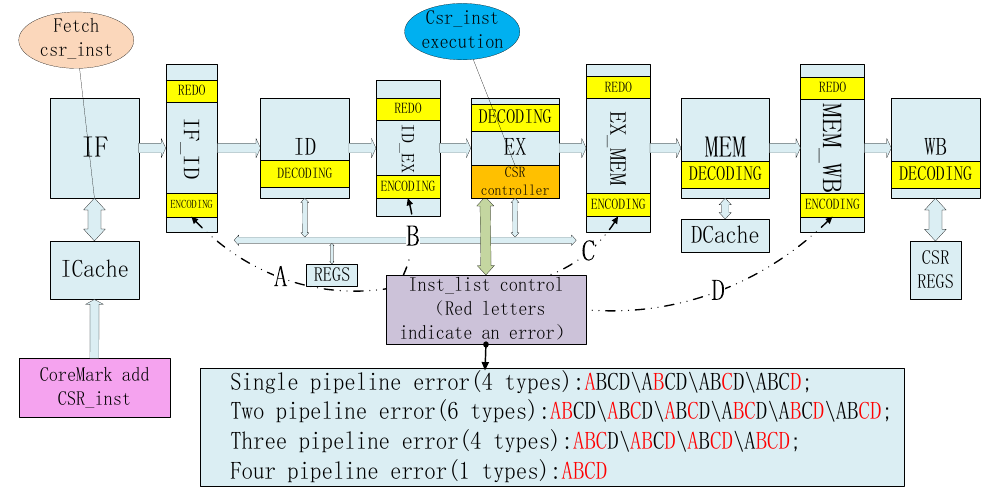
Figure 24. CSR instruction test incentive flow chart.